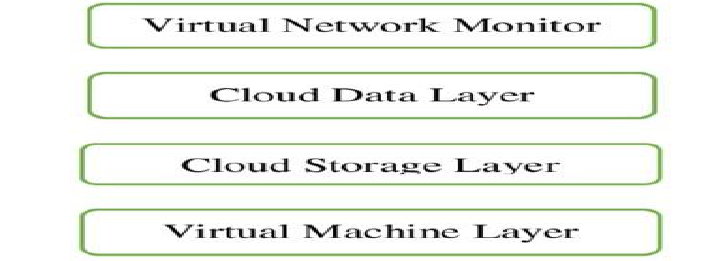
Figure 2 . Layer System of Cloud